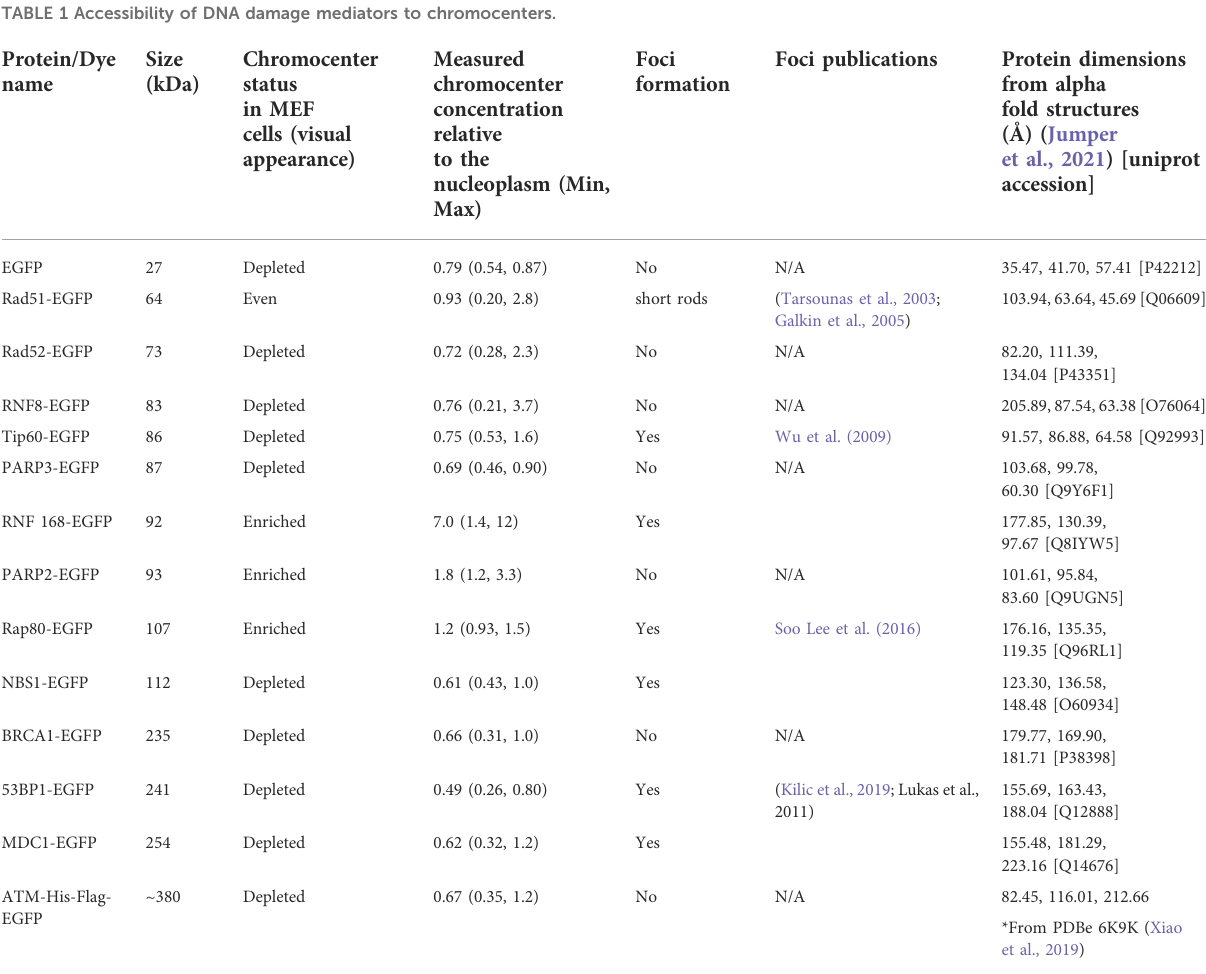
TABLE 1 Accessibility of DNA damage mediators to